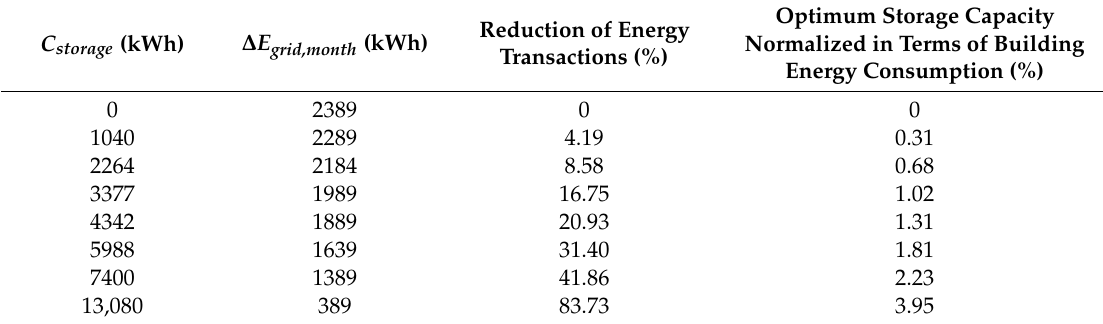
Table 4. Optimization of electrical energy storage